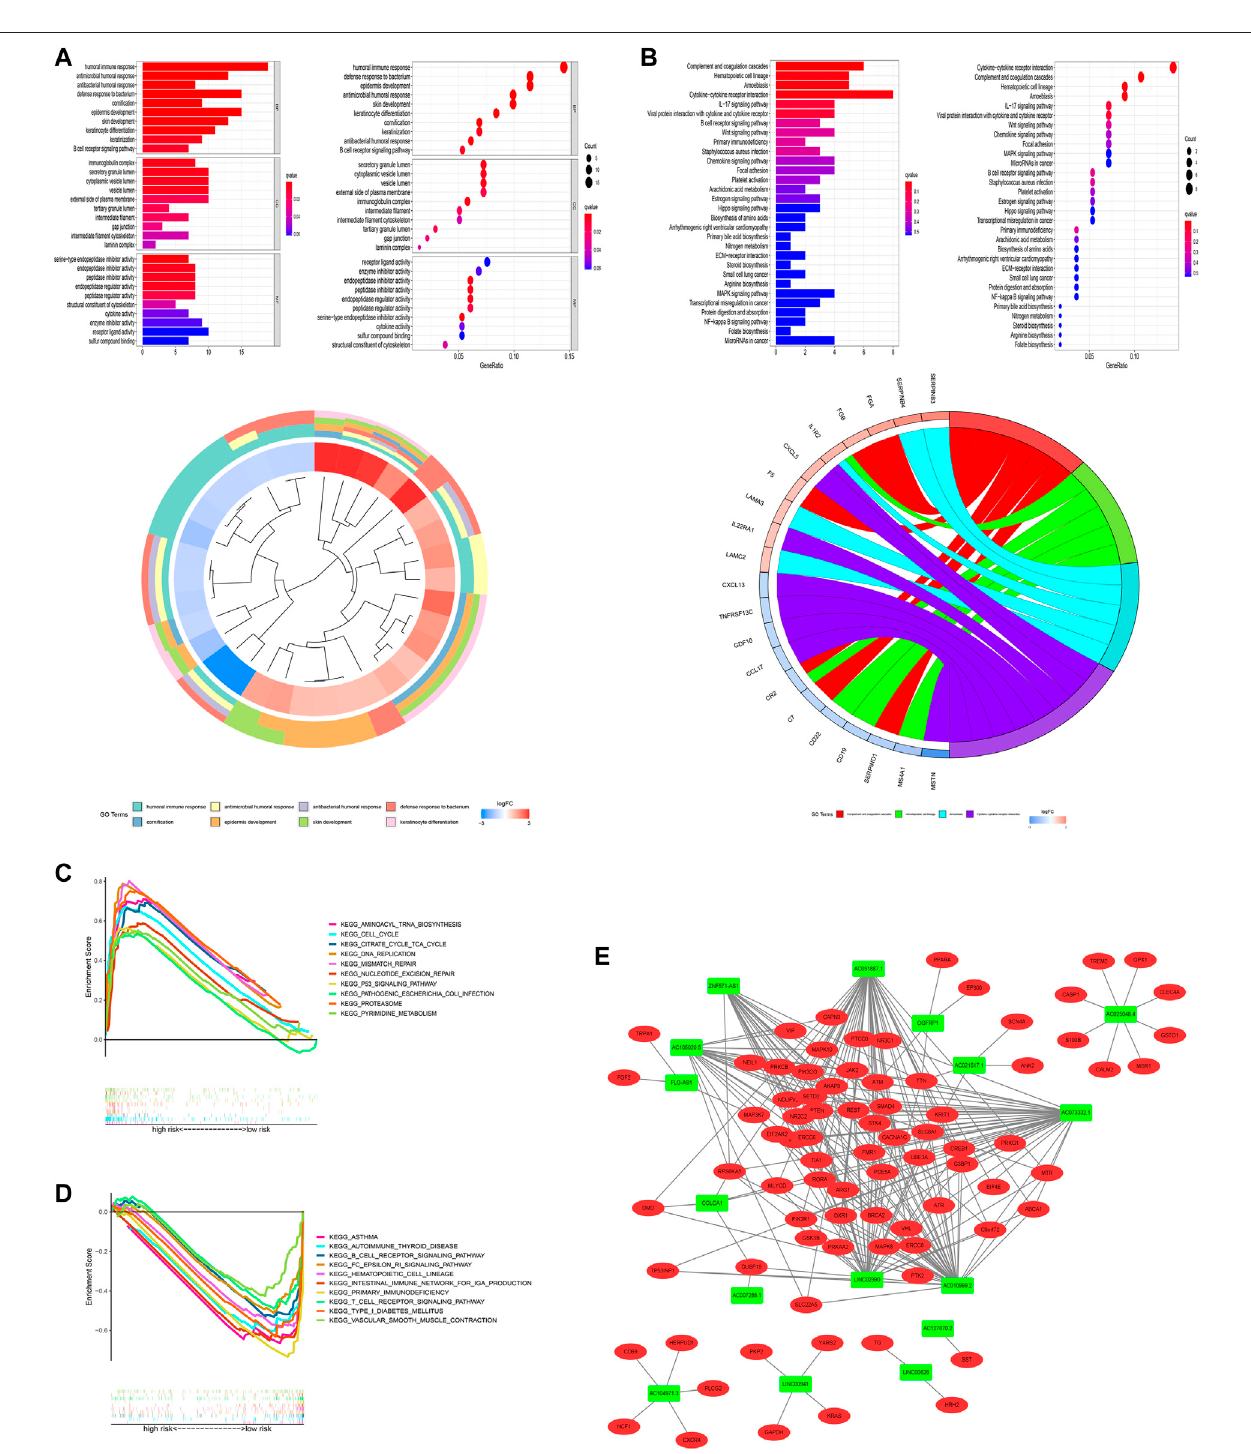
FIGURE 11 | Functional analysis. (A) Top 10 classes of GO enrichment terms based on DEGs between two groups, including biological process (BP), cellular component (CC), and molecular function (MF). (B) Top 30 pathways of KEGG enrichment terms. (C) Gene set enrichment analysis of the top 10 pathways signi fi cantly enriched in the high-risk group. (D) Gene set enrichment analysis of the top 10 pathways enriched considerably in the low-risk group. (E) Cytoscape of lncRNA – mRNA co-expression network. Green nodes represent lncRNAs, while red nodes represent mRNAs.